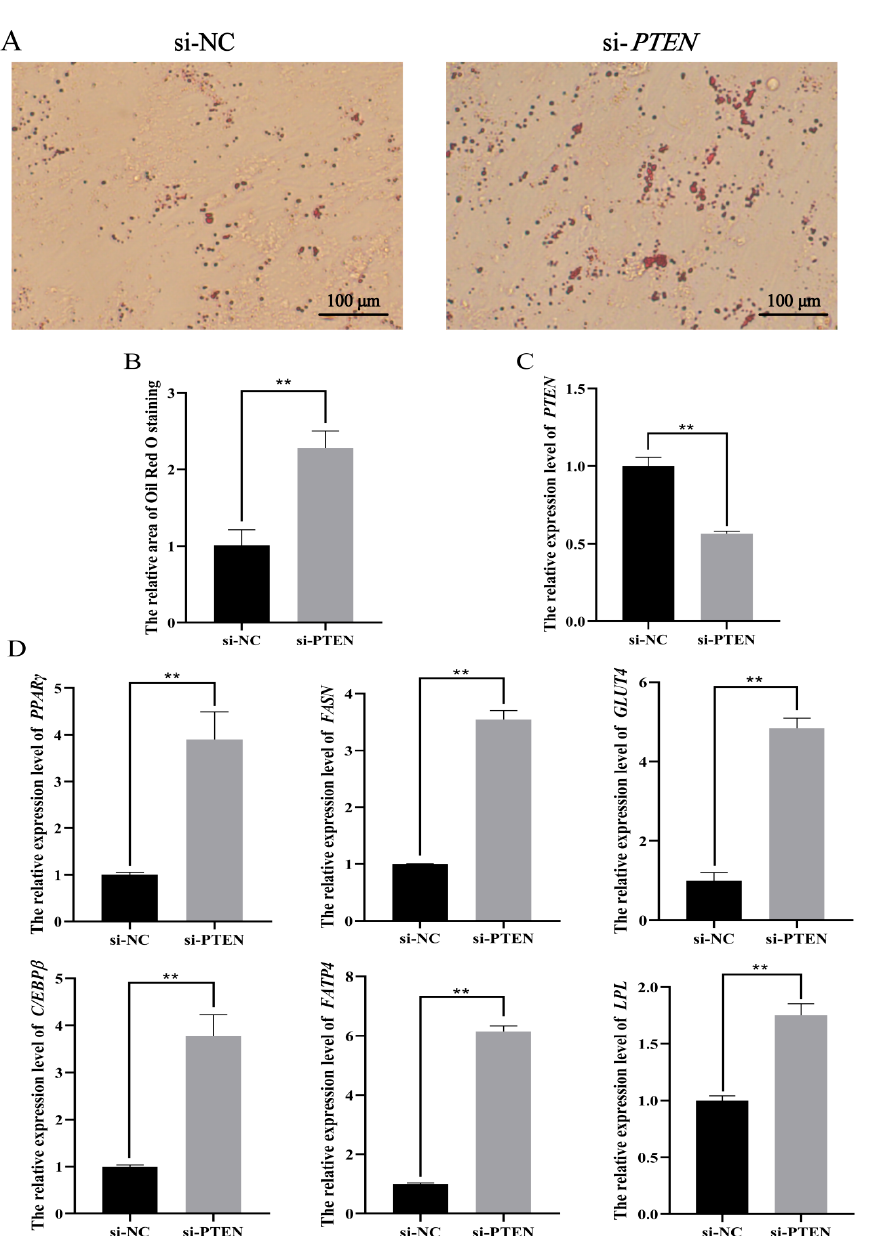
Figure 9. PTEN inhibited preadipocyte differentiation. si- PTEN or negative control (NC) were transfected into ovine preadipocytes. ( A ) Oil Red O staining was performed in differentiated ovine preadipocytes after PTEN silence. ( B ) The areas of Oil Red O staining were counted using the ImageJ software. ( C , D ) The expression levels of PTEN and adipogenesis marker genes were detected after transfection of PTEN siRNA in preadipocytes. The results are depicted as the mean ± SD ( n = 3), ** p < 0.01.